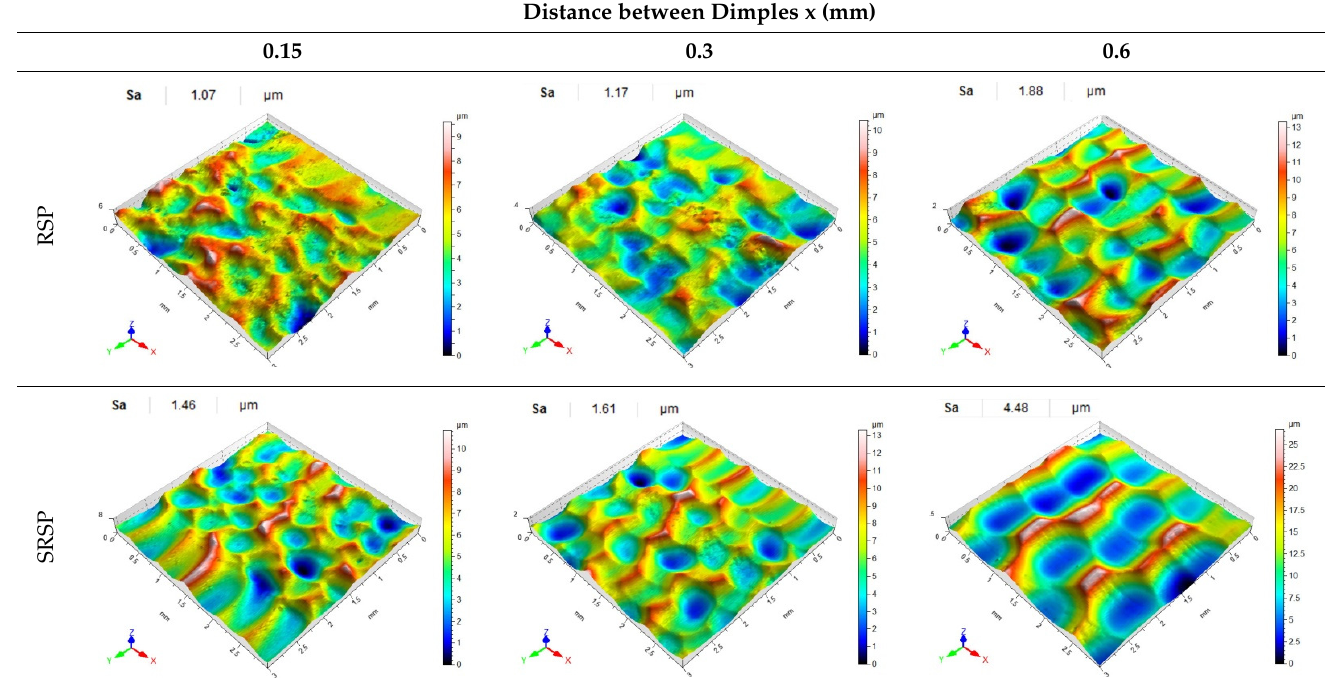
Table 6. Effect of the distance between the dimples on the Sa roughness parameter and surface topography (impact energy E = 100 mJ, ball diameter D = 10 mm).